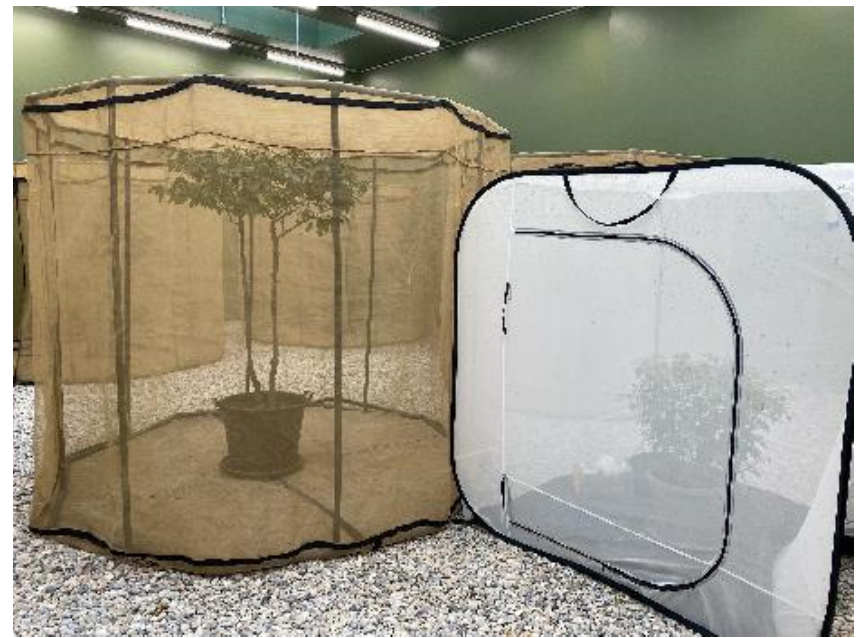
Figure 3. Walk in field cage for insect sexual behavior studies. (Photocredit: C. de Beer). A field evaluation of the mating competitiveness of a 40-year-old G. p. gambiensis col- ony indicated that the sterile males were able to induce nearly complete sterility in the wild female population when a sterile to wild male ratio of 10:1 was obtained [108]. Fur- thermore, a study on the performance of the BKF and Senegal (SEN) strains in an urban area of Senegal showed lower daily mortality rates for the SEN strain, but the BKF strain was more competitive [109]. 5.3. Tsetse Symbionts Tsetse flies harbor several bacterial symbionts (gut microbiota and endosymbionts) that play an essential role in their biology (Figure 4), e.g., the endosymbiont Wigglesworthia glossinidia complements the tsetse diet by producing B vitamins [110]. In addition, Sodalis glossinidius , Wolbachia and Spiroplasma reside in tsetse flies [54,111], and although no clear beneficial role has been linked to these symbionts to date, Sodalis seems to enhance trypa- nosome infection, and Wolbachia has been shown to affect many aspects of the biology of its hosts, including host reproduction, development, immunity and behavior [112,113]. Knowledge of tsetse symbiosis is important to understand the fecundity, nutrition and immunity of the flies in order to develop novel approaches for their control [114,115].